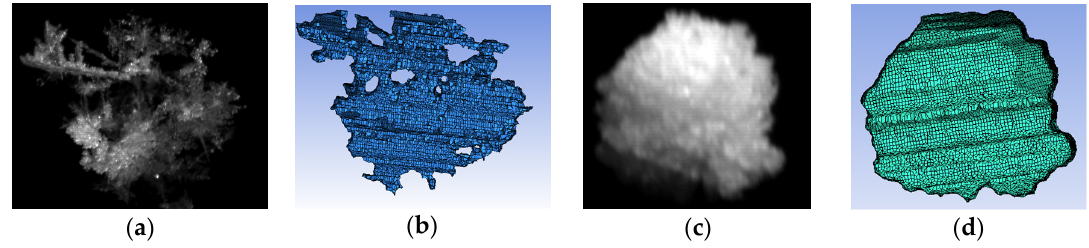
Figure 6. Examples of 3D shape reconstruction of snow particles from three high-resolution MASC photographs using the visual hull (VH) image processing method (VHMC) and ANSYS ICEM CFD meshing software: recorded MASC images and 3D reconstructed shapes (in the form of meshes of quadrilateral patches suitable for method of moments (MoM) surface integral equation (SIE) scattering modeling) for ( a ) and ( b ) a snow aggregate, ( c ) and ( d ) a mostly rimed graupel.